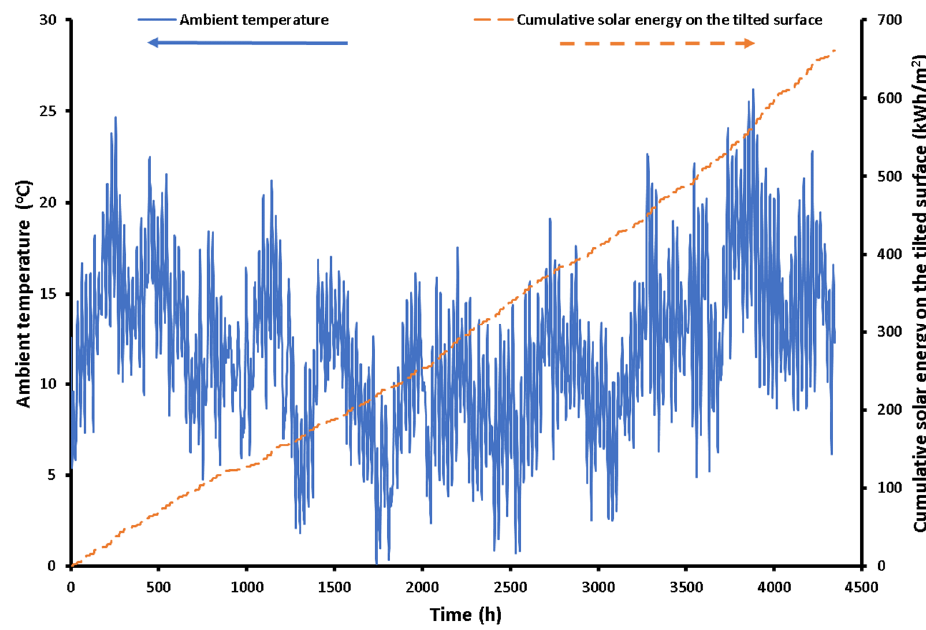
Figure 4. Climate conditions of Athens in the winter period (1st October to 30th April).